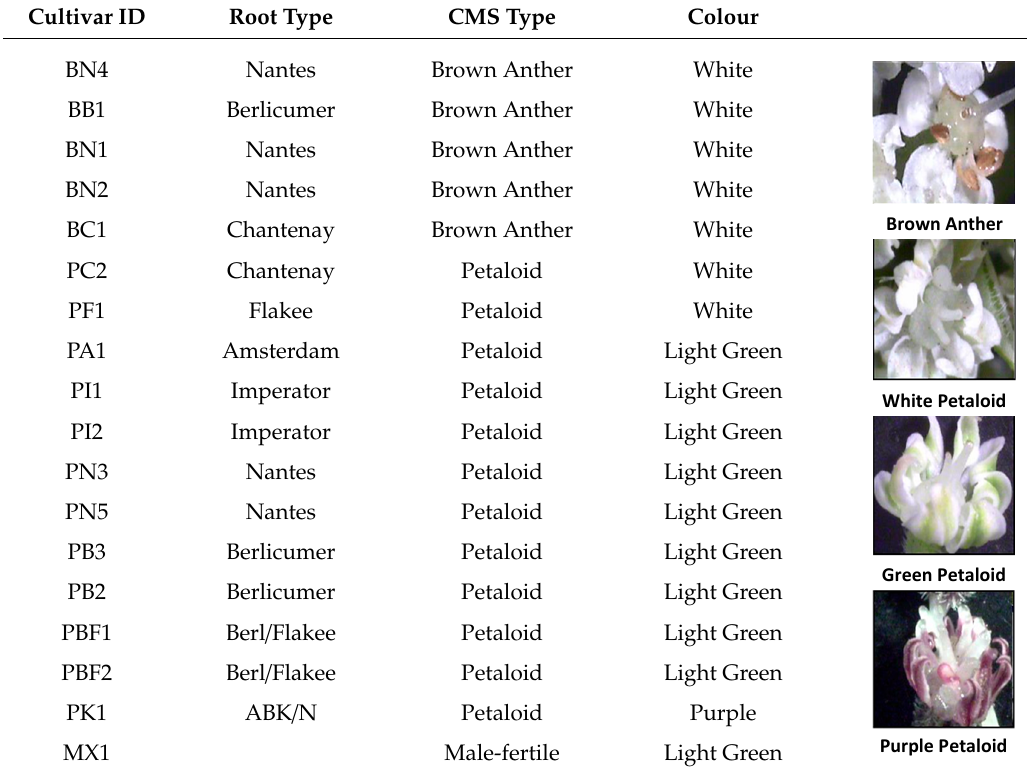
Table 1. Descriptions of the 17 carrot cultivars and cytoplasmically male-sterile (CMS) plant types used in field trial A.